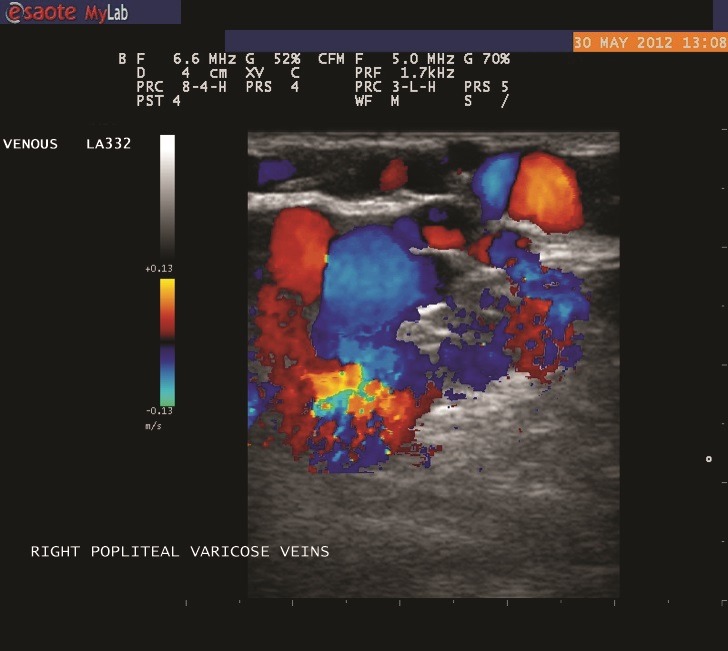
Doppler ultrasound showing varicose veins with atypical distribution in the right lower limb.